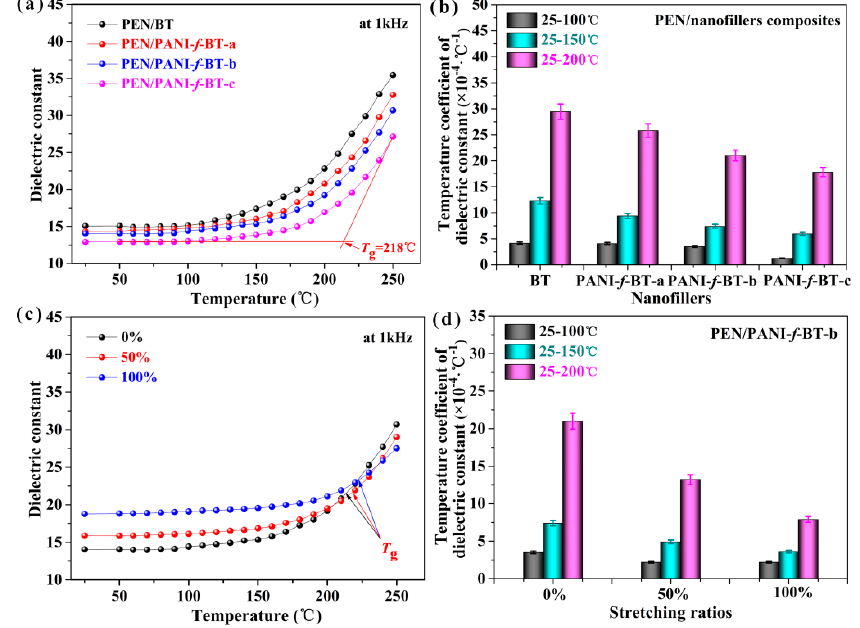
Figure 10. ( a ) Permittivity-temperature dependences and ( b ) temperature coefficients of dielectric constant of the nanocomposites; ( c ) permittivity-temperature dependences and ( d ) temperature coefficients of dielectric constant of PEN/PANI- f -BT-b at different stretching ratios.